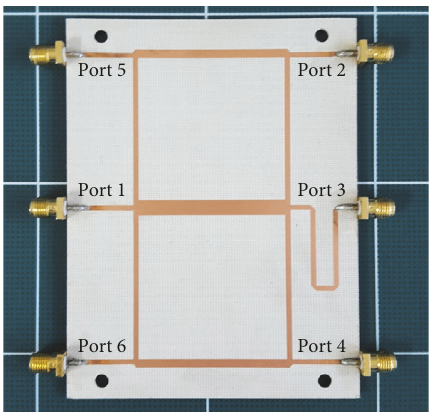
Figure 3: Prototypes of the designed couplers with 0 shorting